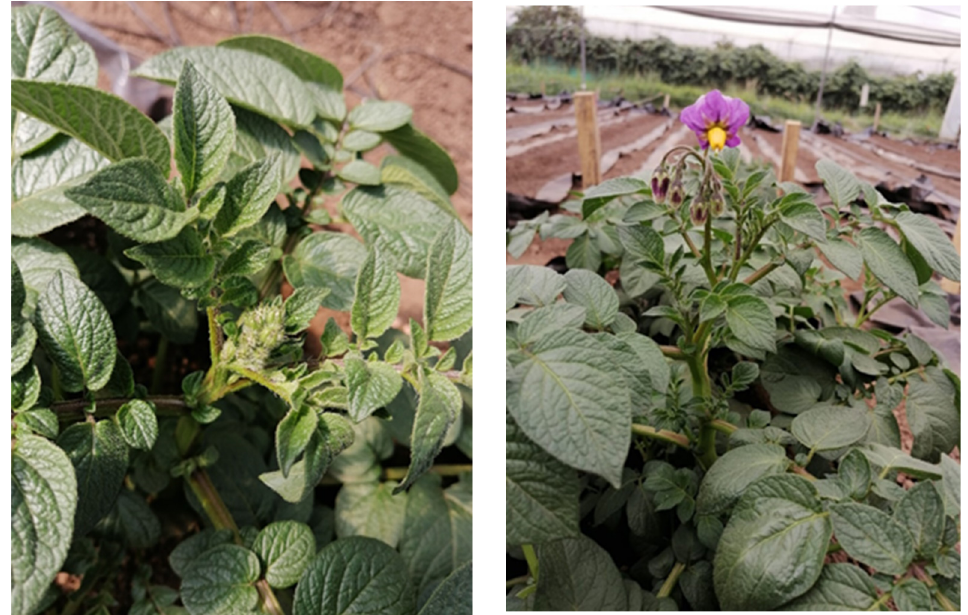
Figure A2. Maximum tuberization stage: left and right photographs show the development stage of flowering. Gómez et al. report that the stage of maximum tuberization and beginning of filling coincides with flowering.